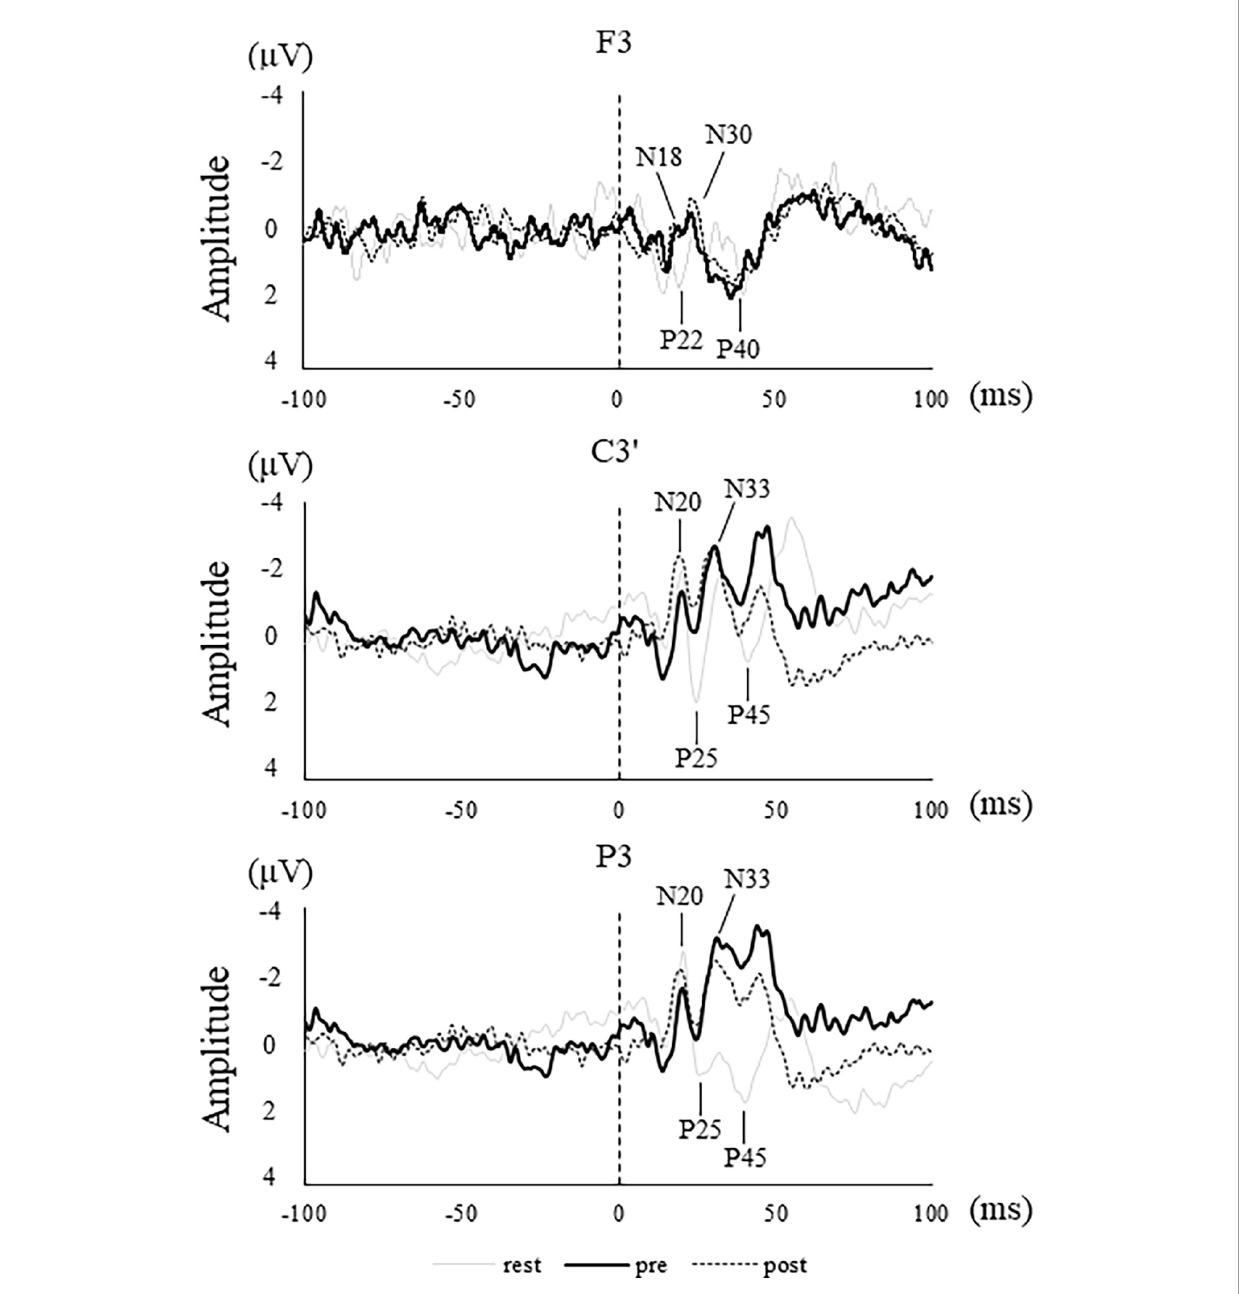
FIGURE5 SEPs waveform in a representative participant in rest (thin solid line), pre (solid line), and post (dotted line) at each electrode site. Vertical dotted lines indicate stimulus